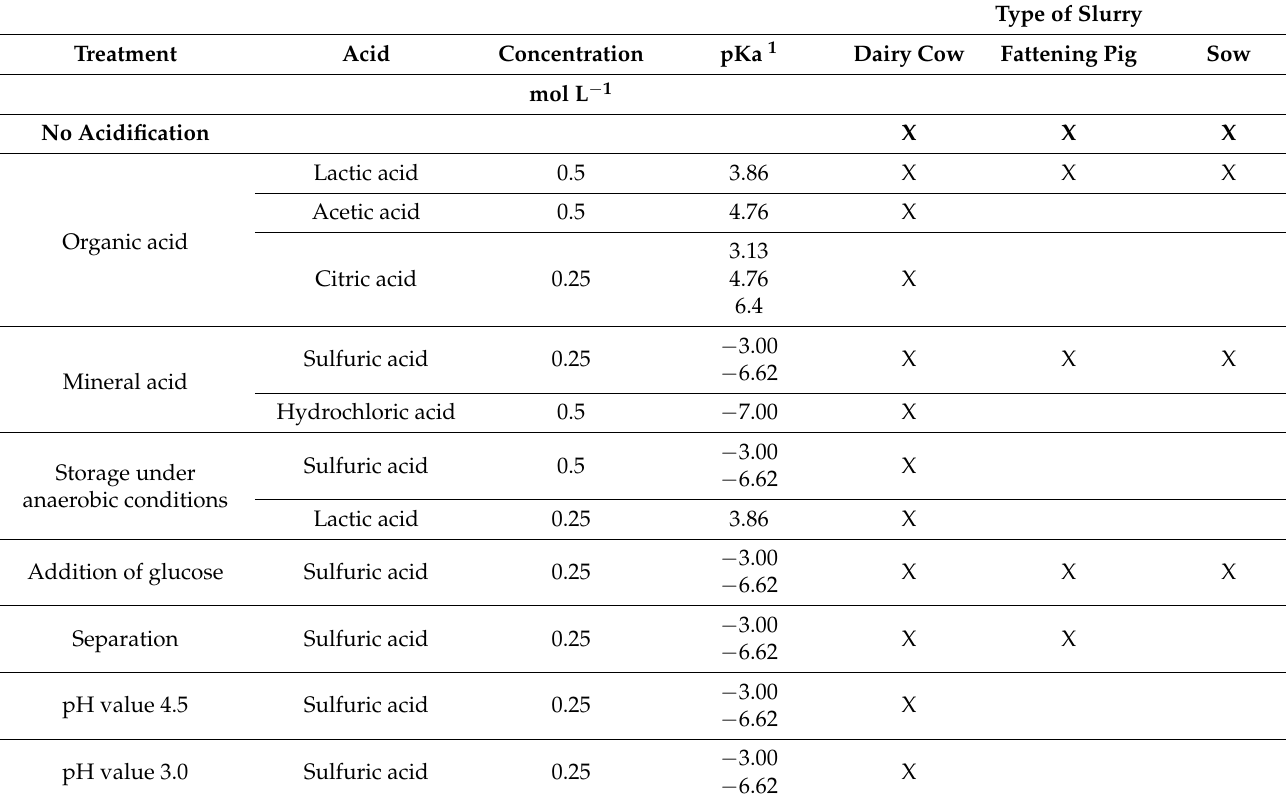
Table 1. Overview of the variants depending on the type of acid, slurry, and (previous) treatment.